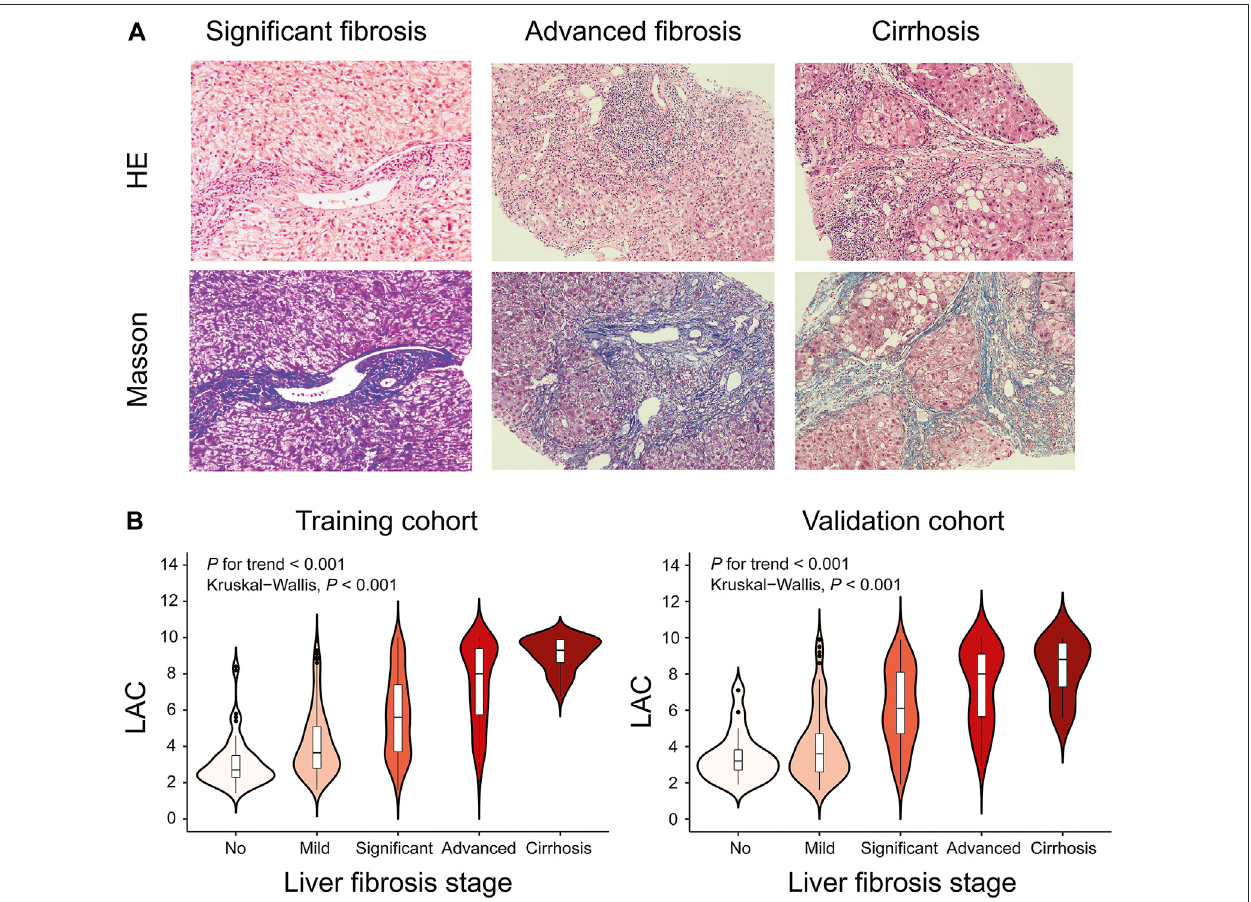
FIGURE2| RepresentativeHistologicalAssessmentsandCorrelationbetweenLACandDifferentFibrosisStages.Blackshortdashesinthemiddlearethemedian values, and the bars represent the interquartile ranges. The whiskers show 95% CI, whereas the shape of the violin displays the frequencies of the values. (A) Hematoxylin-eosin(HE)andMassontrichromestainingofDILIpatientswithdifferent fi brosisstages(originalmagni fi cation × 200).Forsigni fi cant fi brosis,regionalballoon- like changes, scattered focal necrosis, and apoptotic bodies in the hepatocytes were observed, and the portal area was enlarged with proliferation of the fi brous tissue.Foradvanced fi brosis, hepatocytefusion,focalnecrosis,and bridgingnecrosiswereeasily observable, and theportalareawasenlarged withtheformationofthe fi brousseptum.Forcirrhosis,regionalballoon-likechangesinthehepatocyteswereobservedwithmorespottedfocalnecrosisandoccasionalfusionfocalnecrosis.The hepatic lobule structure was disordered with the formation of pseudolobule. (B) Violin plots showing median LAC values according to the fi brosis stages in the training cohort or validation cohort. Liver fi brosis stages (no, Ishak fi brosis score (cid:1) 0; mild, Ishak fi brosis score (cid:1) 1 or two; signi fi cant, Ishak fi brosis score (cid:1) 3; advanced, Ishak fi brosis score (cid:1) 4; cirrhosis, Ishak fi brosis score (cid:1) 5 or 6).